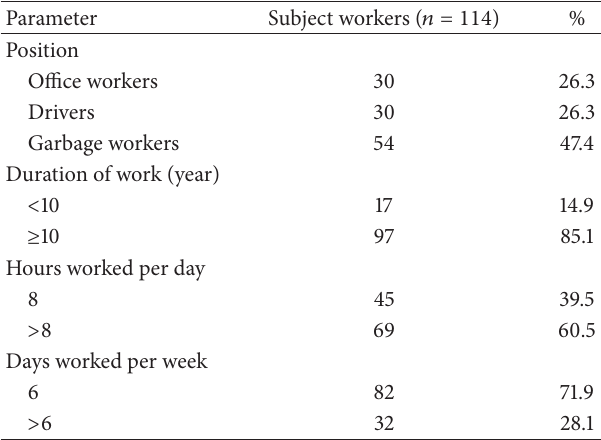
Table 2: Work characteristic of the subject